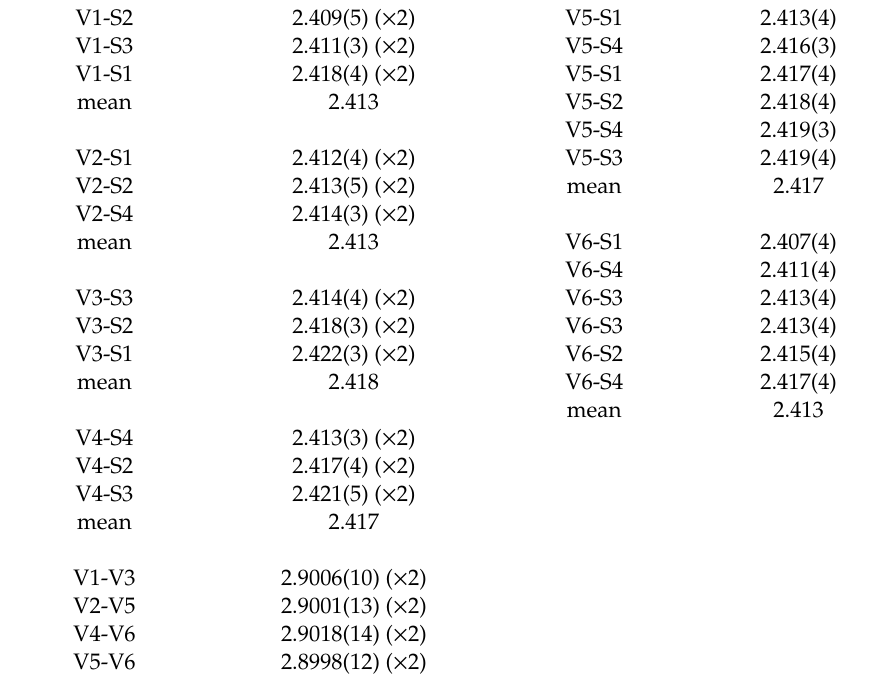
Table 4. Bond distances (Å) in the structure of eliopoulosite.